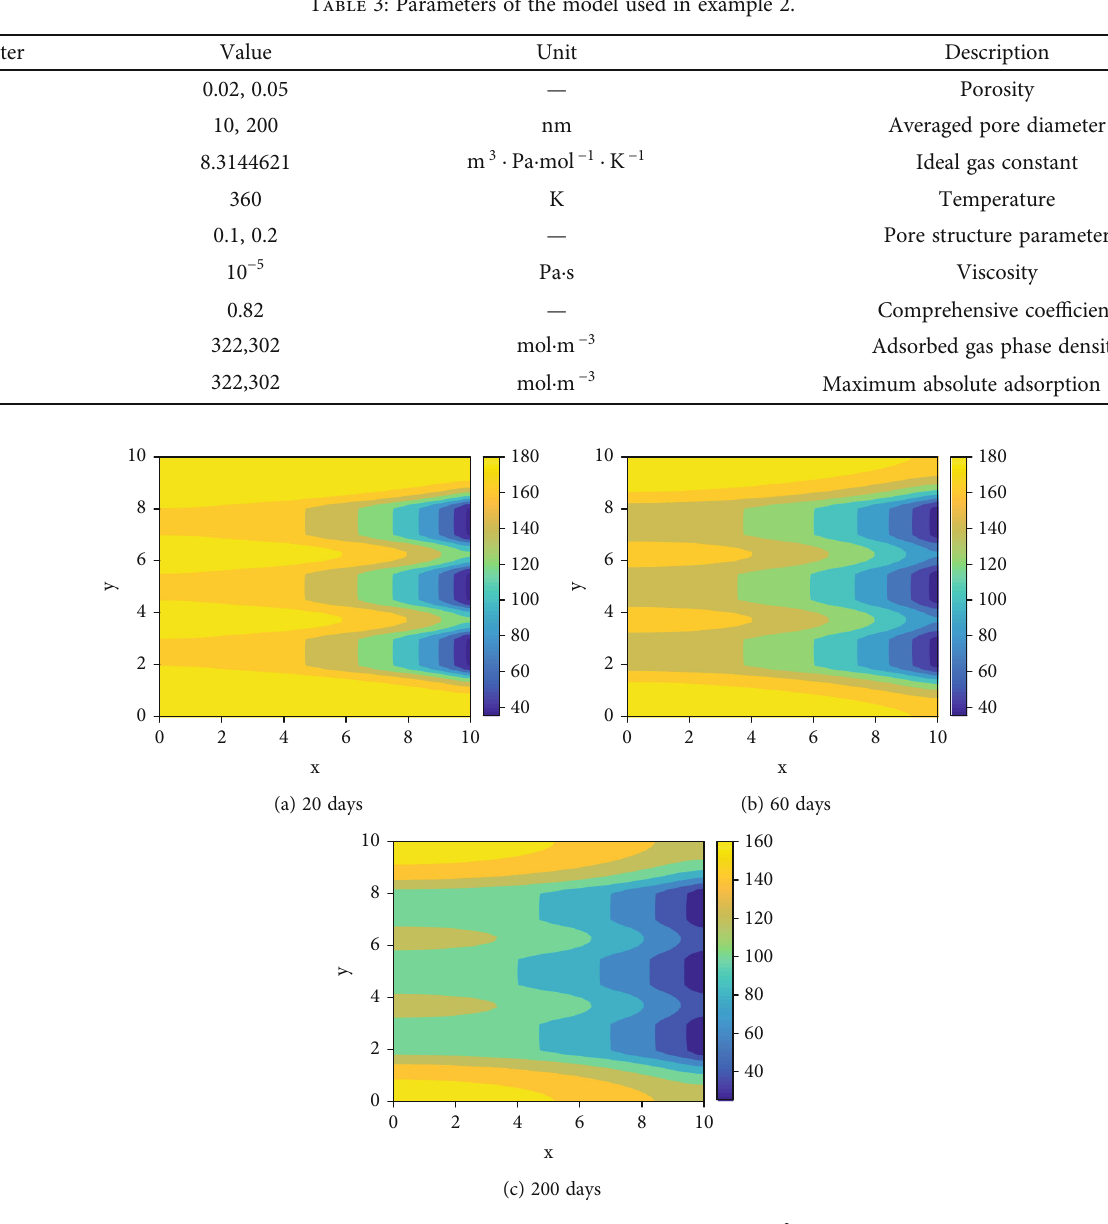
Figure 10: Gas density distributions in example 2 with c